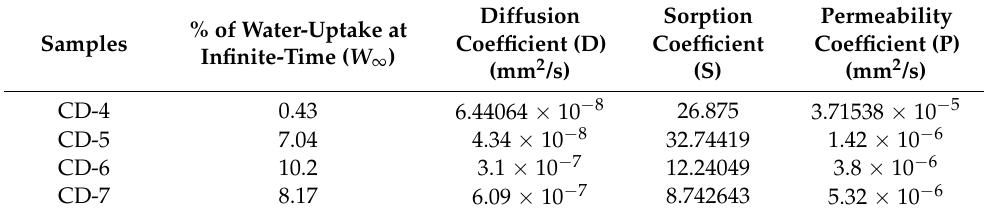
Table 3. Diffusion, sorption, and permeability study of graphite-loaded composites.